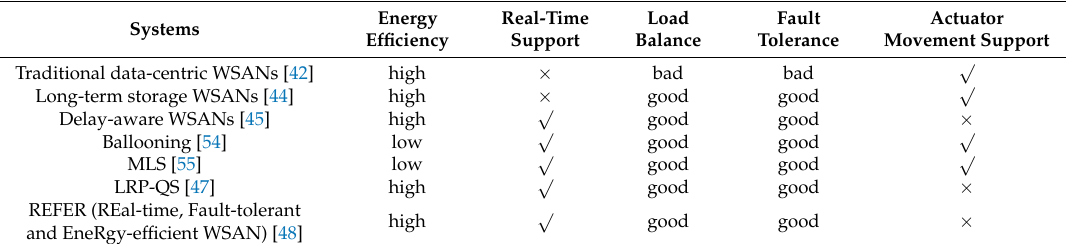
Table 1. Performances of different WSANs-based Edge computing